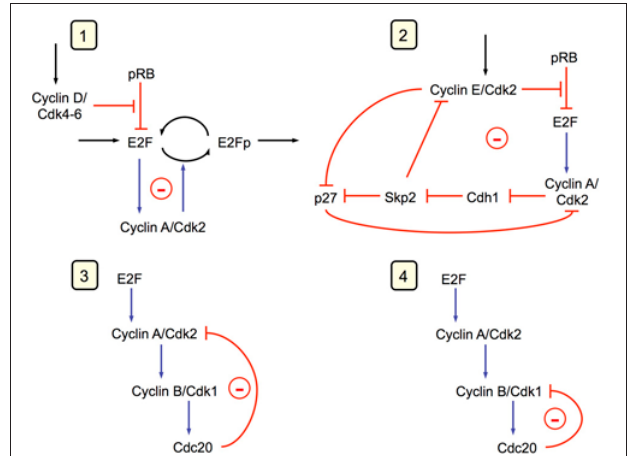
FIGURE 6 | The Cdk network driving the mammalian cell cycle contains multiple oscillatory circuits (Gérard and Goldbeter, 2009). Four circuits containing negative feedback loops are capable of generating sustained oscillations in the model for the mammalian cell cycle. Cyclin A/Cdk2 is present in the four circuits, each of which can generate on its own sustained oscillations. In circuits 1 and 2 , oscillations can occur in the absence of cyclin B/Cdk1, which is responsible for the entry of cells into mitosis. Oscillations in Cdk2, which controls DNA replication, occur in these circuits without any peak in Cdk1, a phenomenon known as endoreplication (see Figure 7 ). In circuits 3 and 4 , mitotic oscillations involving repetitive activation of cyclin B/Cdk1 can occur, based on a negative feedback exerted via the protein Cdc20, which allows the degradation of either cyclin A or cyclin B. In physiological conditions, all four oscillatory circuits synchronize to produce the ordered, repetitive activation of the different modules forming the Cdk network that drives the mammalian cell cycle (see Figure 2A